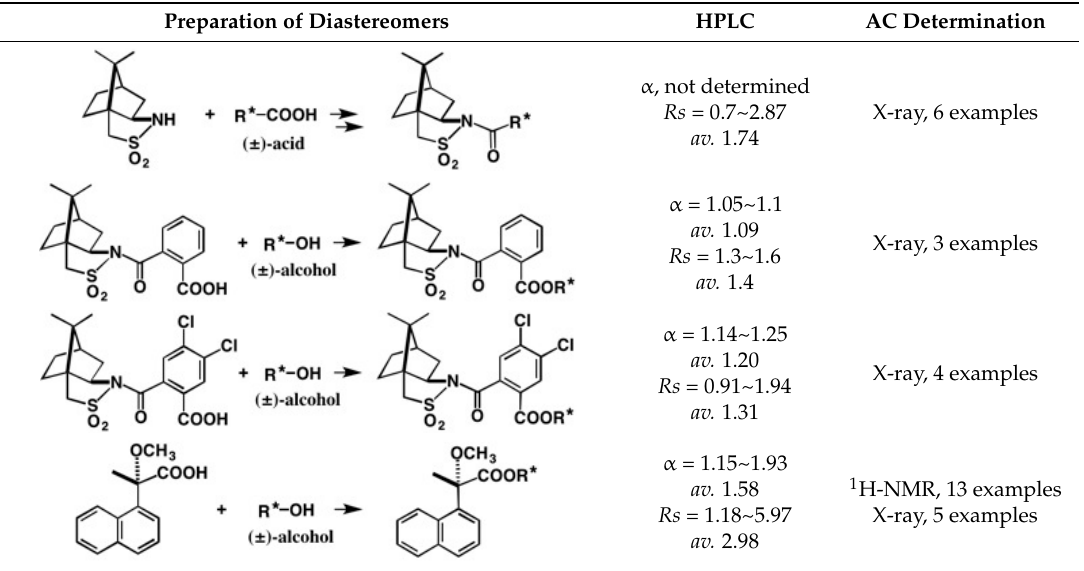
Molecules 2016 , 21 , 1328 Molecules 2016 , 21 , 1328 (average α = 1.20), M α NP esters (average α = 1.58). So, in most cases, HPLC separation on a (average α = 1.20), M α NP esters (average α = 1.58). So, in most cases, HPLC separation on a preparative scale was possible. Table 1. Summary of the preparation of diastereomers, HPLC separation, and AC determination by Table 1. Summary of the preparation of diastereomers, HPLC separation, and AC determination by Table 1. Summary of the preparation of diastereomers, HPLC separation, and AC determination by Table 1. Summary of the preparation of diastereomers, HPLC separation, and AC determination by Table 1. Summary of the preparation of diastereomers, HPLC separation, and AC determination by X-ray crystallography and/or 1 H-NMR diamagnetic anisotropy. X-ray crystallography and/or 1H-NMR diamagnetic X-ray crystallography and/or 1H-NMR diamagnetic anisotropy. X-ray crystallography and/or 1H-NMR diamagnetic anisotropy. X-ray crystallography and/or 1H-NMR diamagnetic anisotropy. Preparation of Diastereomers HPLC Preparation of Diastereomers HPLC Preparation of Diastereomers Preparation of Diastereomers